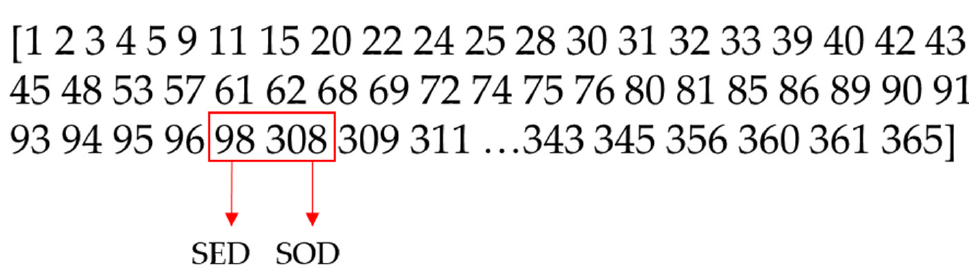
Figure 2. Examples of the SOD and SED defined (the number represents the Julian day with snow cover in the calendar year).